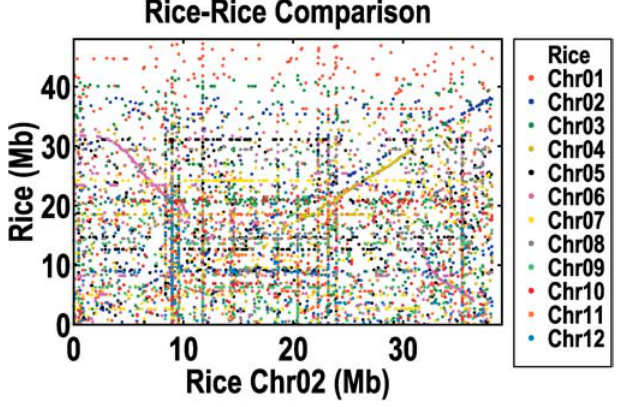
Figure 9. A View of All Duplications Found on Rice Chromosome 2 In contrast to Figure 6, where we featured those cDNAs with one and only one TBlastN homolog, here we show all detectable TBlastN homologs, up to a maximum of 1,000 per cDNA. DOI: 10.1371/journal.pbio.0030038.g009